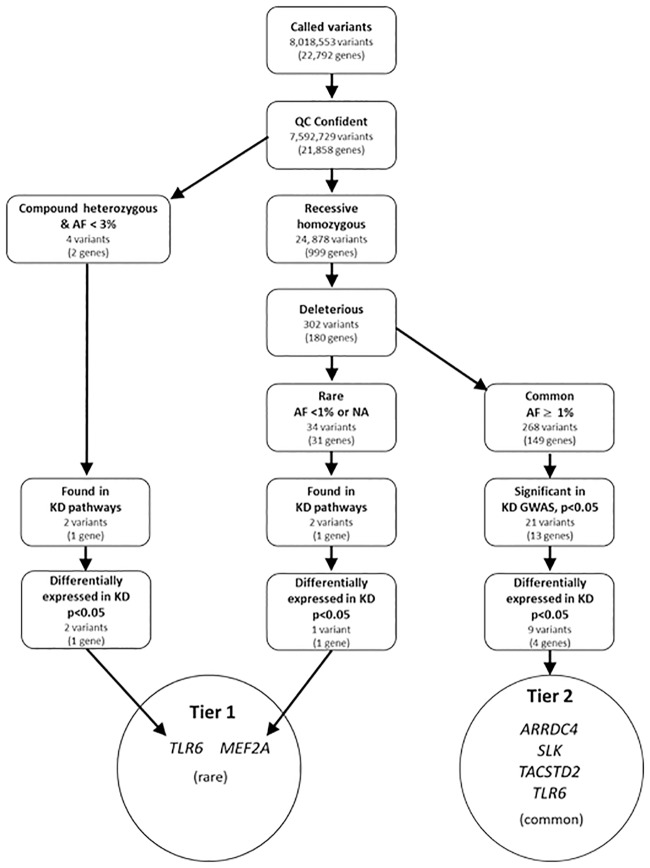
Workflow of variant discovery and validation.The diagram illustrates a discovery and validation workflow starting from called variants in an African American family of six members with two KD-affected children as a discovery analysis on WGS followed by knowledge-based filtering derived from published GWAS, disease pathogenesis, and gene-level validation using differential transcript abundance. Confidence filter: a call quality at least 20 and read depth at least 10. Differentially expressed: ≥ 1.2-fold change between acute and convalescent whole blood transcripts. Abbrv.: AF: allele frequency; NA: not available, GWAS: genome-wide association study; KD: Kawasaki disease; TLR6: Toll-like receptor 6; MEF2A: myocyte enhancer factor 2A; ARRDC4:arrestin domain containing 4; SLK: STE20 like kinase; TACSTD2: tumor-associated calcium signal transducer 2.